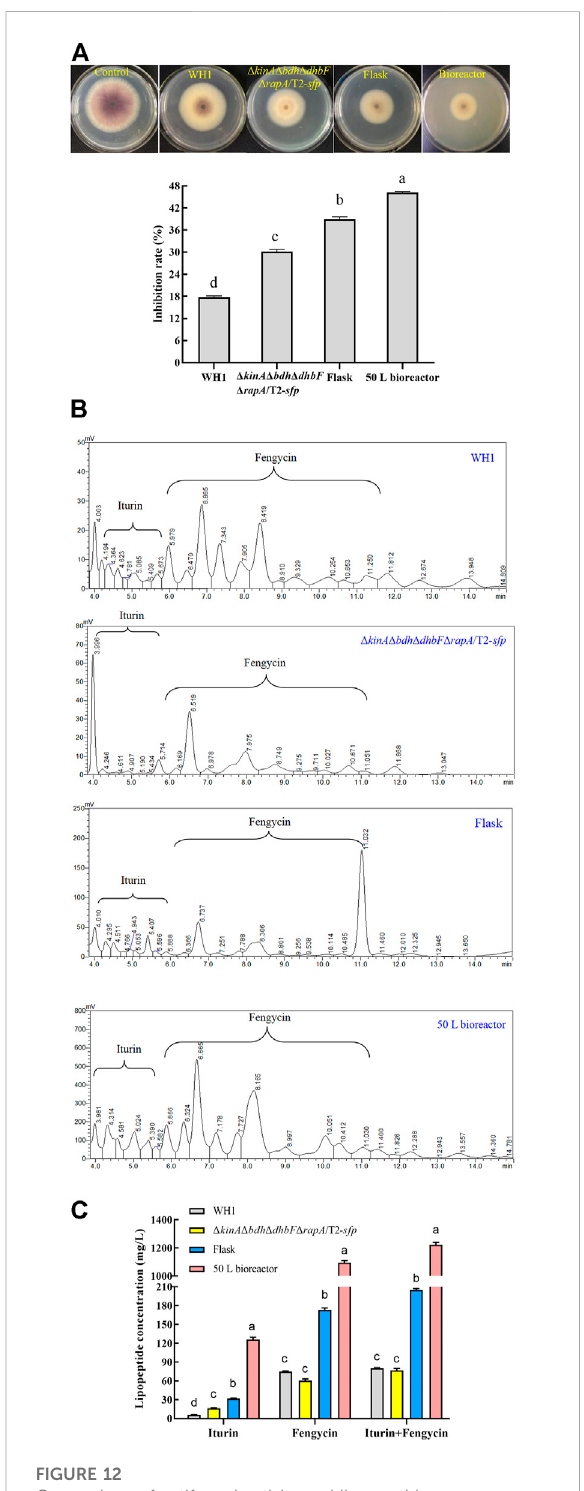
FIGURE 12 Comparison of antifungal activity and lipopeptides productionbetweenWH1and Δ kinA Δ bdh Δ dhbF Δ rapA /T2- sfp . (A) : Antifungal activity. Top: Antifungal activity determined on PDA plates;Bottom:Inhibitionrates. (B) :Analysisoflipopeptidesin the broth by HPLC. (C) : Antifungal lipopeptides titer in the broth